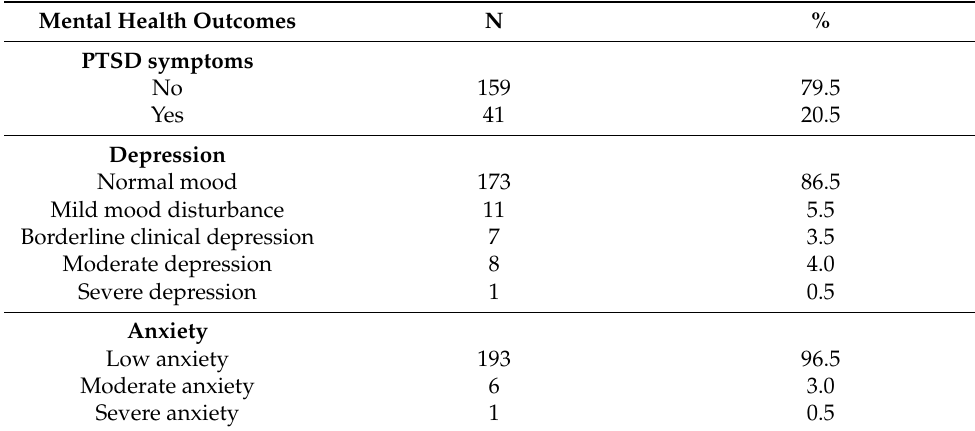
Table 8. Mental health outcomes at 6-month